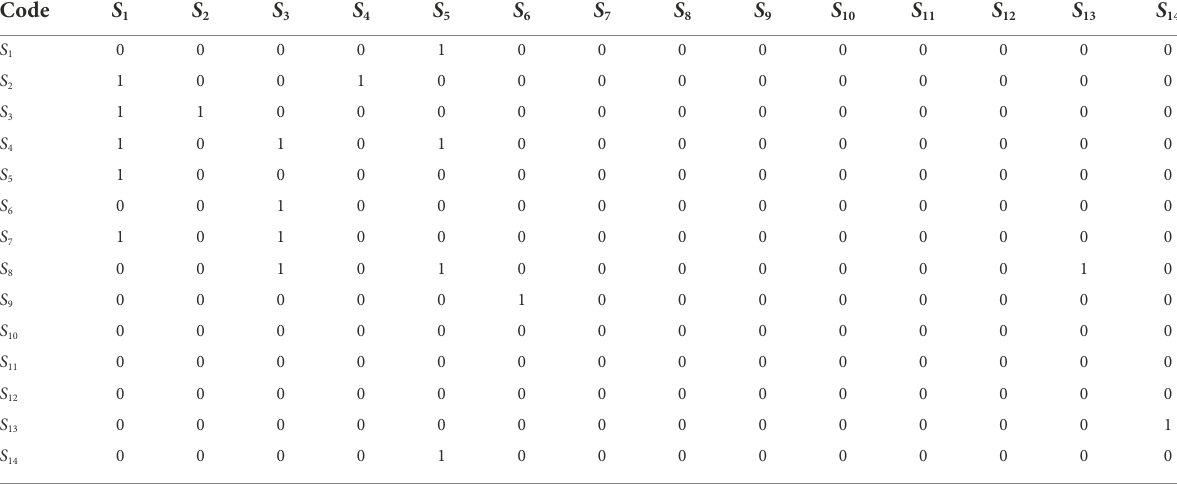
TABLE 3 Adjacency reachability matrix A of expert performance factors. Code